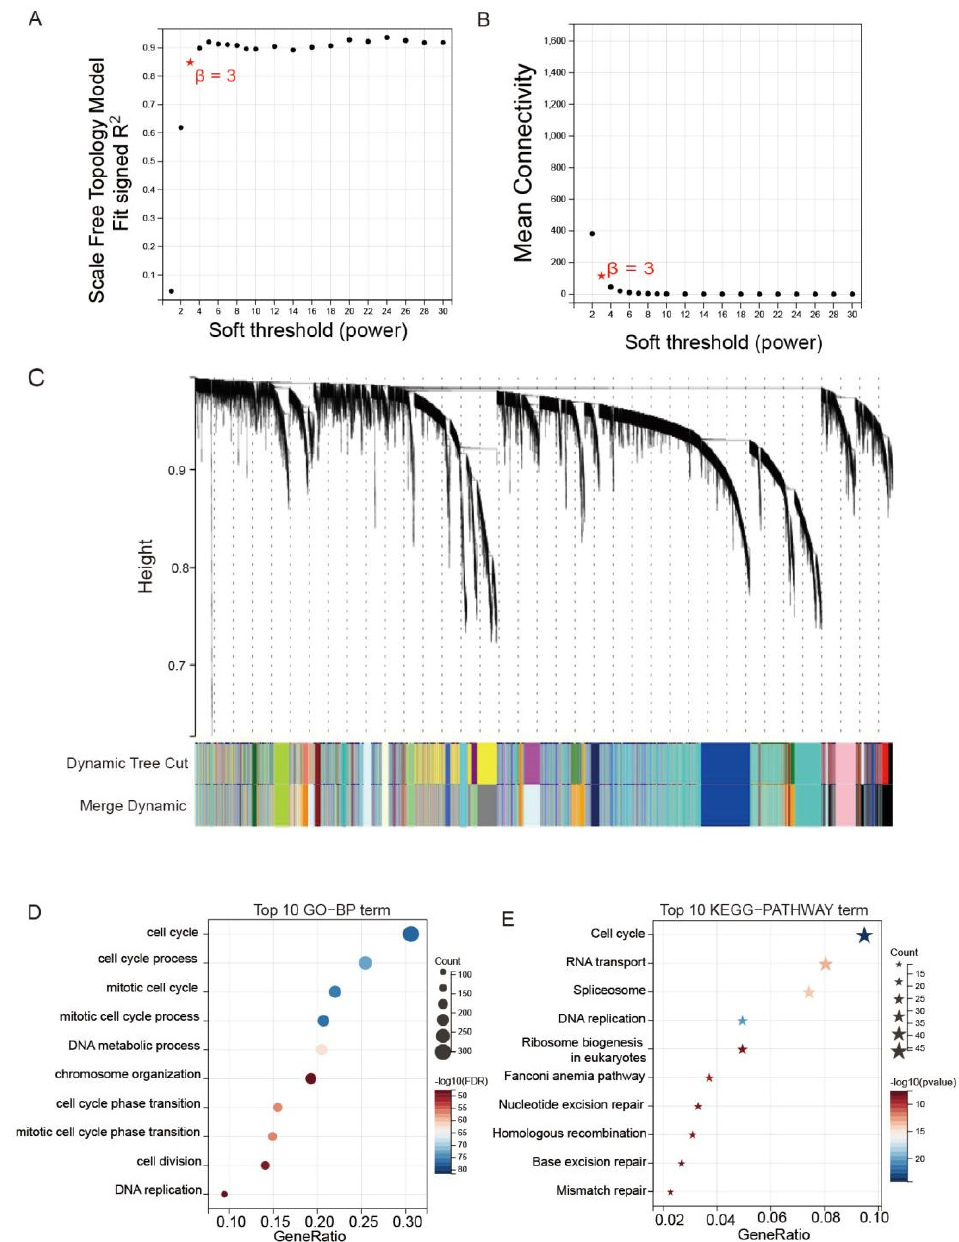
Figure 6. WGCNA was used to identify co-expression module genes relating to DAPK1. ( A ) Association between power and scale-free topology model fit in GSE62254 database. ( B ) Association between power and mean connectivity in GSE62254 dataset. ( C ) Dendrogram of modules identified by WGCNA in the GSE62254 dataset. ( D ) GO-BP analysis of the genes in the blue module. ( E ) KEGG-pathway analysis of the genes in the blue module.